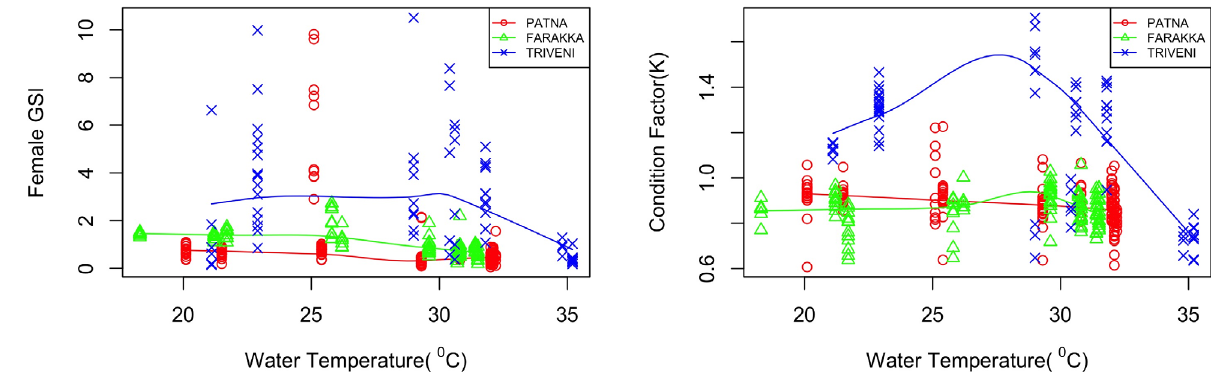
Fig. 4. Smoothed scatterplot showing the effect of spatial location on the GSI – temperature and K – temperature relationship of J. coitor .